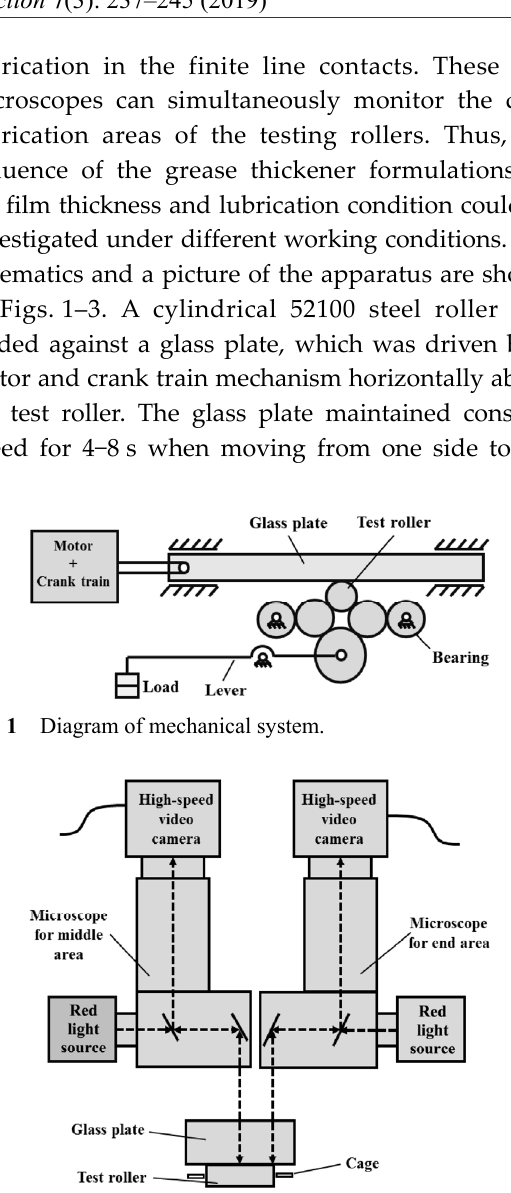
Fig. 2 Diagram of film thickness measuring system.